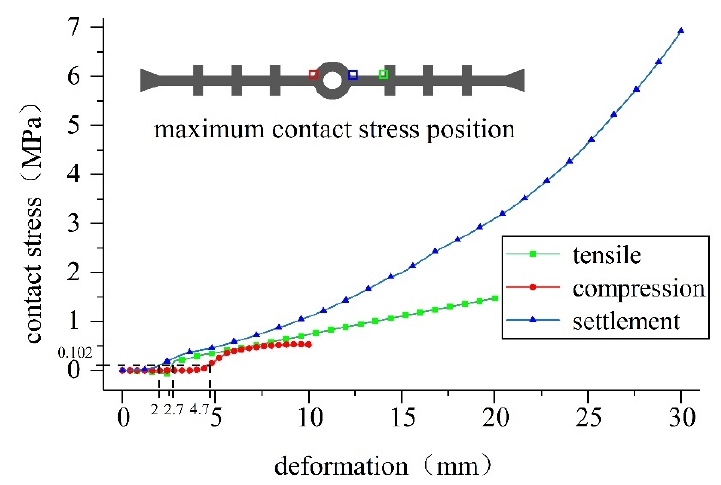
Figure 16. The maximum contact pressure of the waterstop in working condition 1.